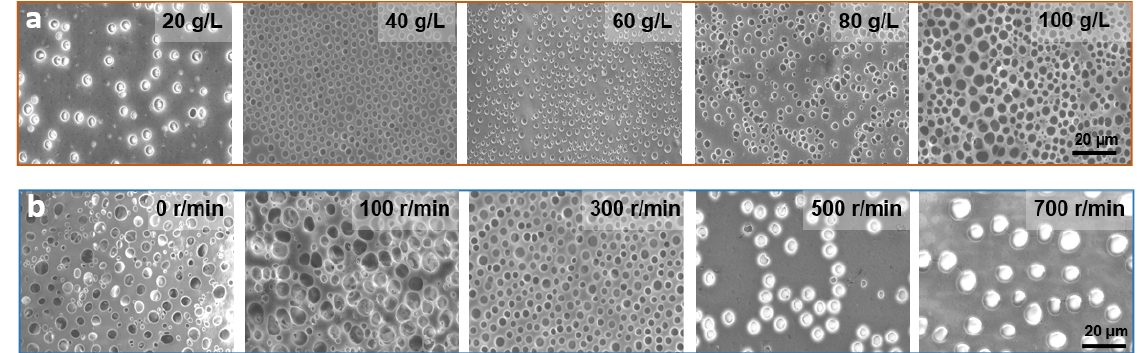
Figure 3. ( a ) SEM images of PS/SBS porous films formed at different concentrations. ( b ) SEM images of PS/SBS porous films formed at different spin coating speeds. Other conditions: the fixed weight ratio of PS/SBS:3:1. Spinning speed:300 r/min , time:6 s.